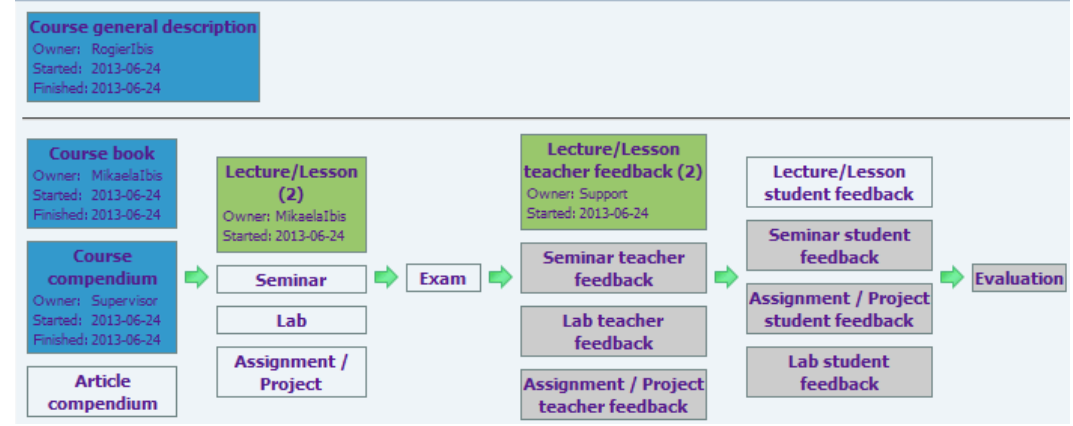
Figure A5. Instance process map from Figure A2 as a user navigation